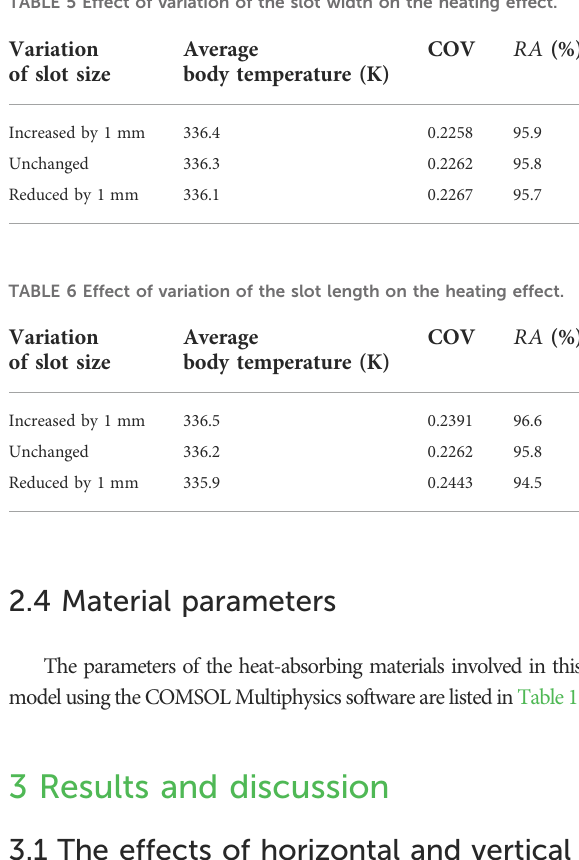
TABLE 5 Effect of variation of the slot width on the heating effect.